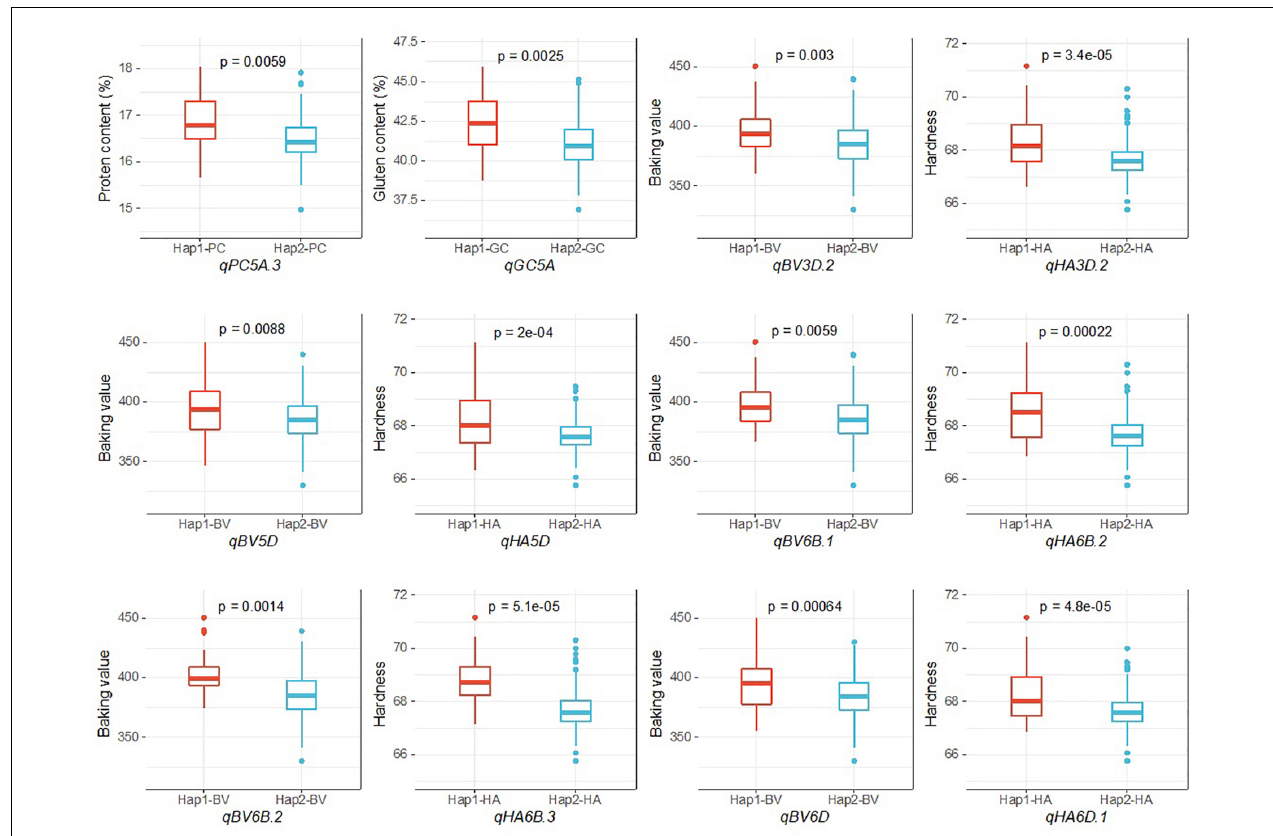
FIGURE 4 | Analysis of the haplotype effects of the stable QTL on chromosomes 3D, 5A, 5D, 6B, and